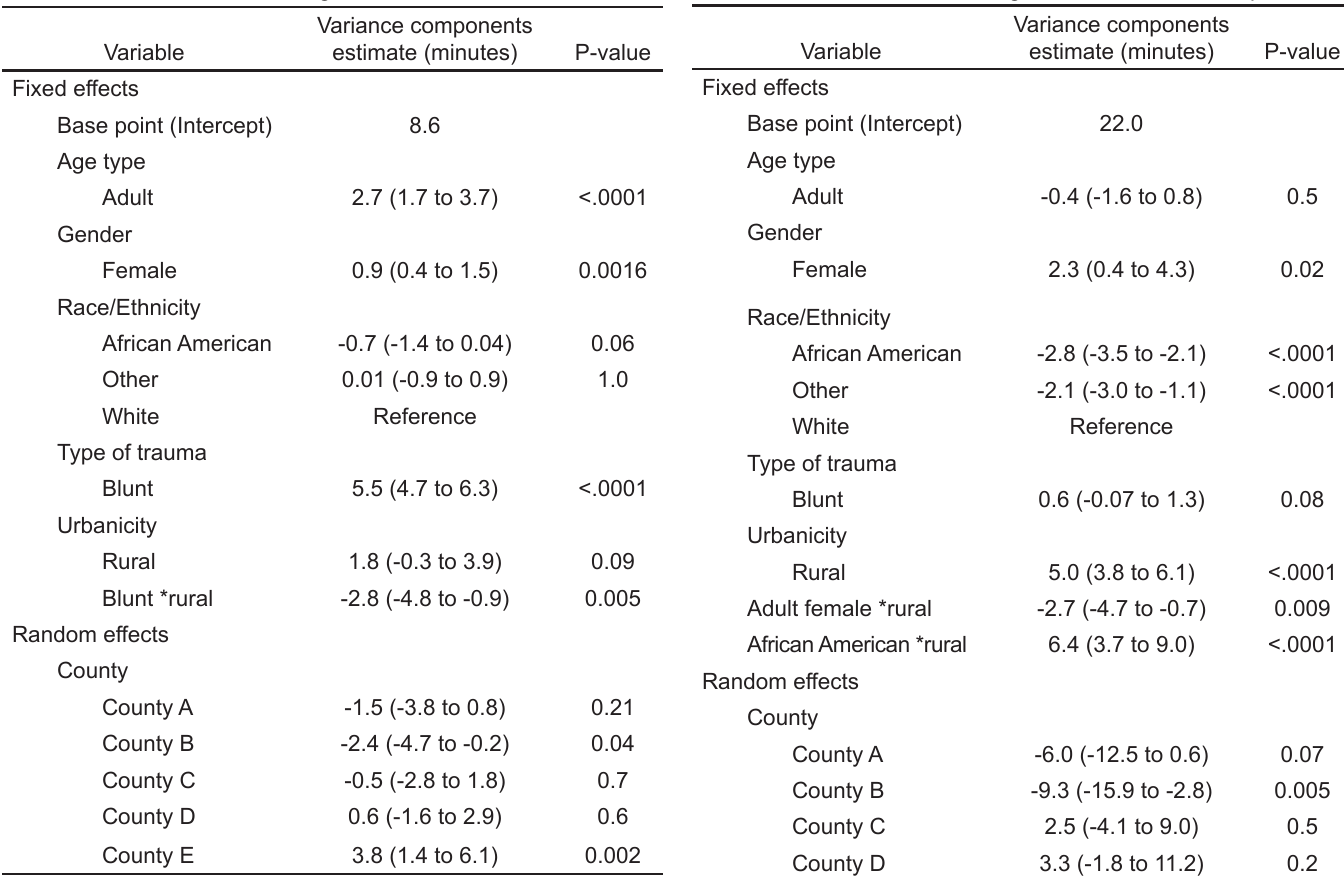
Table 2. Linear mixed-effects regression model for scene time. Table 3. Linear mixed-effects regression model for transport